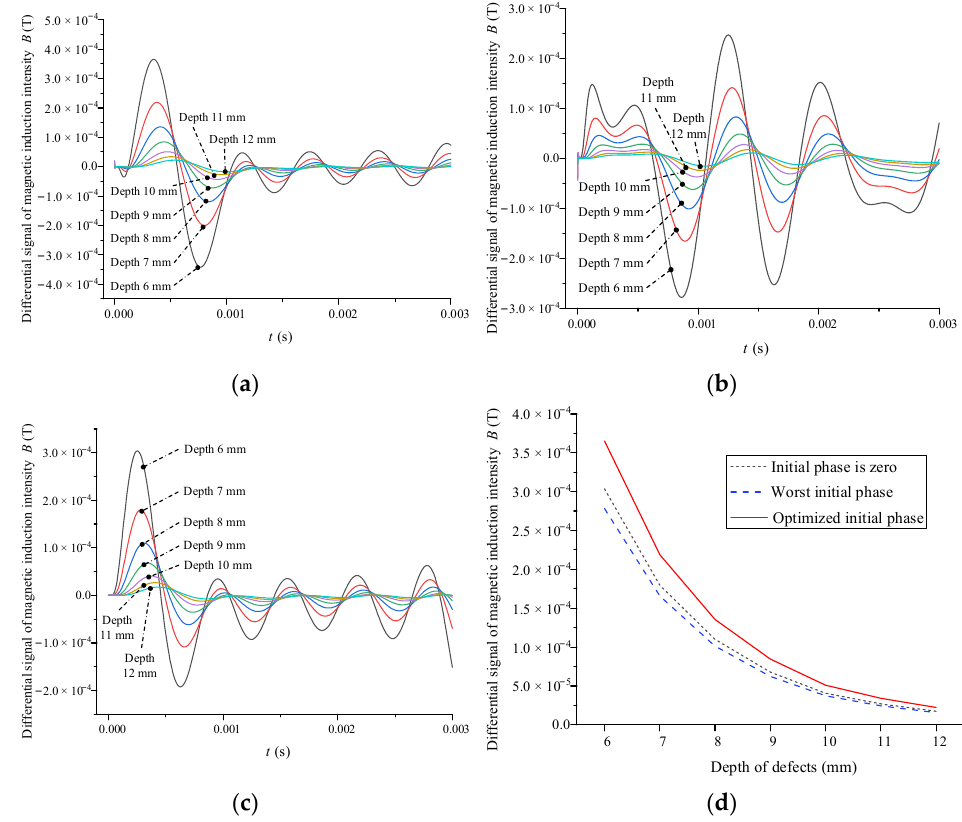
Figure 4. Differential detection simulation signal of magnetic induction intensity when the phase angle of excitation signal is ( a ) optimized, ( b ) the worst and ( c ) zero; ( d ) peak values of the differential pickup signals of magnetic induction intensity under different excitation signals.